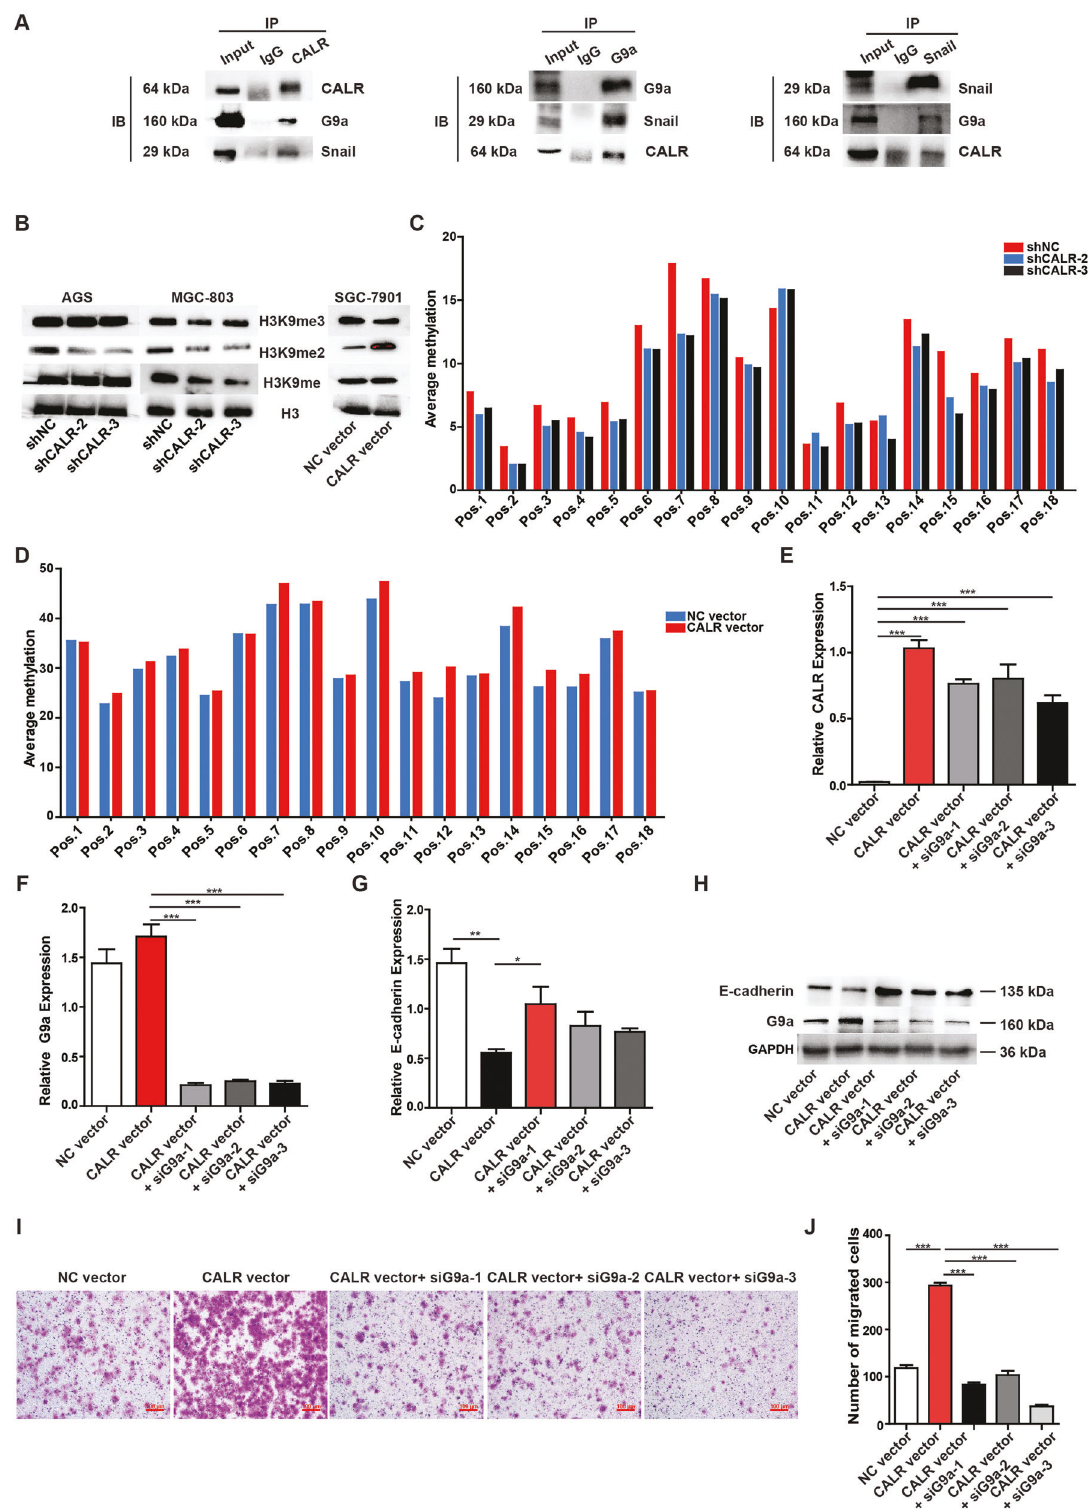
Fig. 5 CALR induces EMT progression by repressing E-cadherin expression mediated by G9a. A The interactions among CALR, G9a and Snail were con fi rmed by immunoprecipitation. IgG was used as a negative control. B Western blot analysis of methyl-histone H3 (Lys9) in CALR overexpressing and knocking down models. C , D Methylation position analysis of E-cadherin promoter in CALR overexpressing and knocking down models via pyrosequencing. E – G RT-qPCR and ( H ) WB analysis the mRNA and protein level of CALR, G9a and E-cadherin in CALR overexpression models transfected with G9a siRNA or siControl. I , J Representative images of G9a siRNA counteracting the acceleration of CALR on GC cells migration in CALR overexpressing